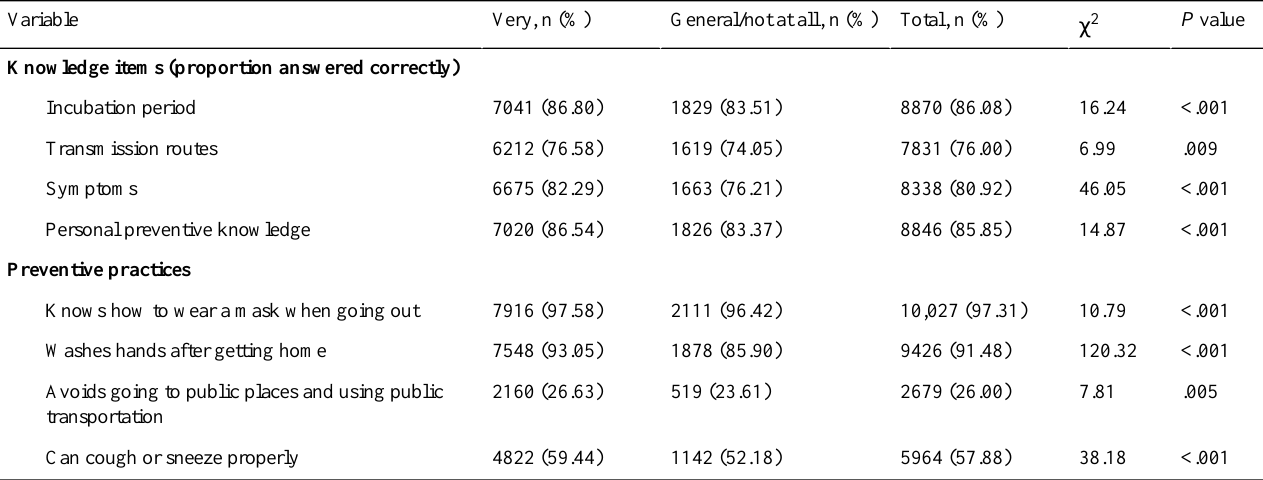
Table 4. Concerns about COVID-19 according to related knowledge and preventive practices.